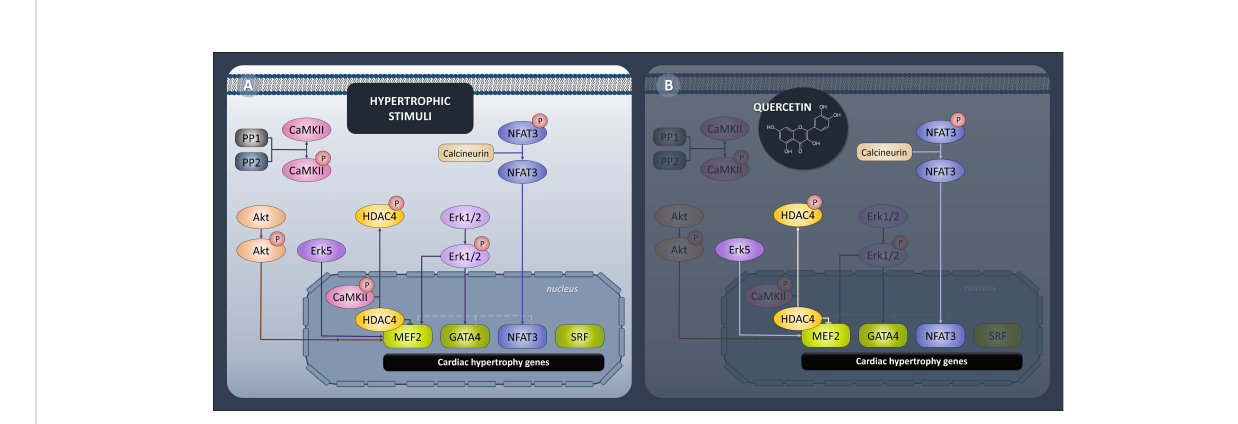
FIGURE 6 Diagrammatic representation of epigenetic and transcriptional control of hypertrophic signaling in heart. (A) Generally accepted protein pathways mediating cardiac hypertrophy. (B) Pathways targeted by quercetin in ZDF (Zucker Diabetic Fatty) rats. Quercetin attenuated expression of transcription factors MEF2, GATA4 and NFAT3 and downregulated upstream effectors HDAC4, calcineurin and